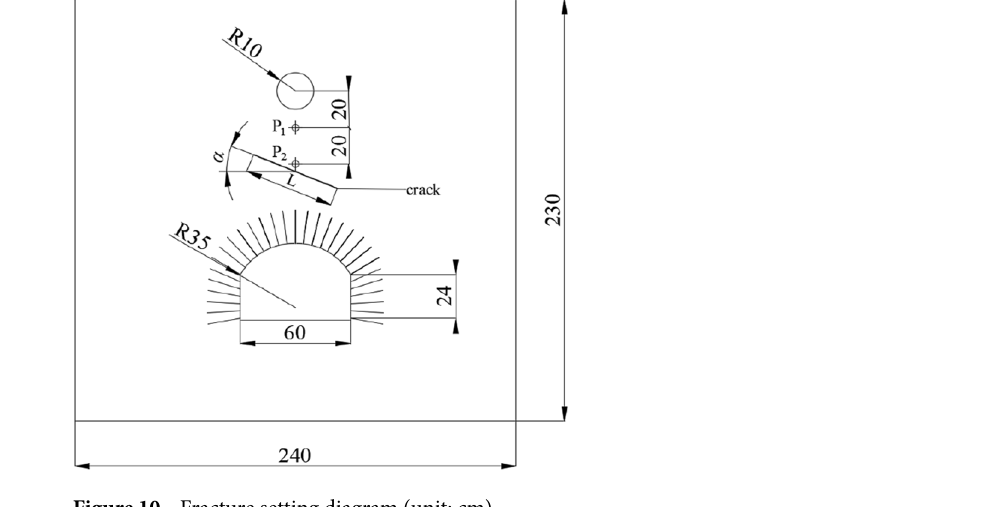
Figure 10. Fracture setting diagram (unit: cm).